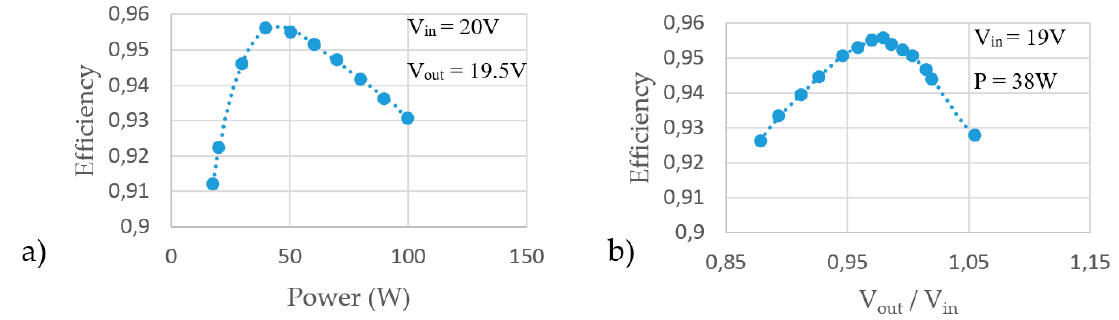
Figure 3. Two typical characteristics of DAB converter efficiency. ( a ) efficiency versus output current, ( b ) efficiency versus input, output voltage difference. Other operating point parameters available in the figure.